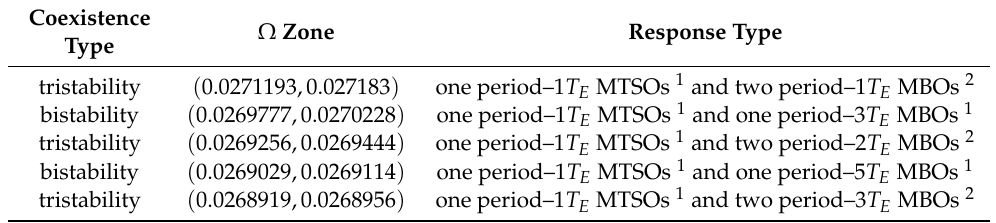
Table 4. Coexistence of the responses of whole system (3).